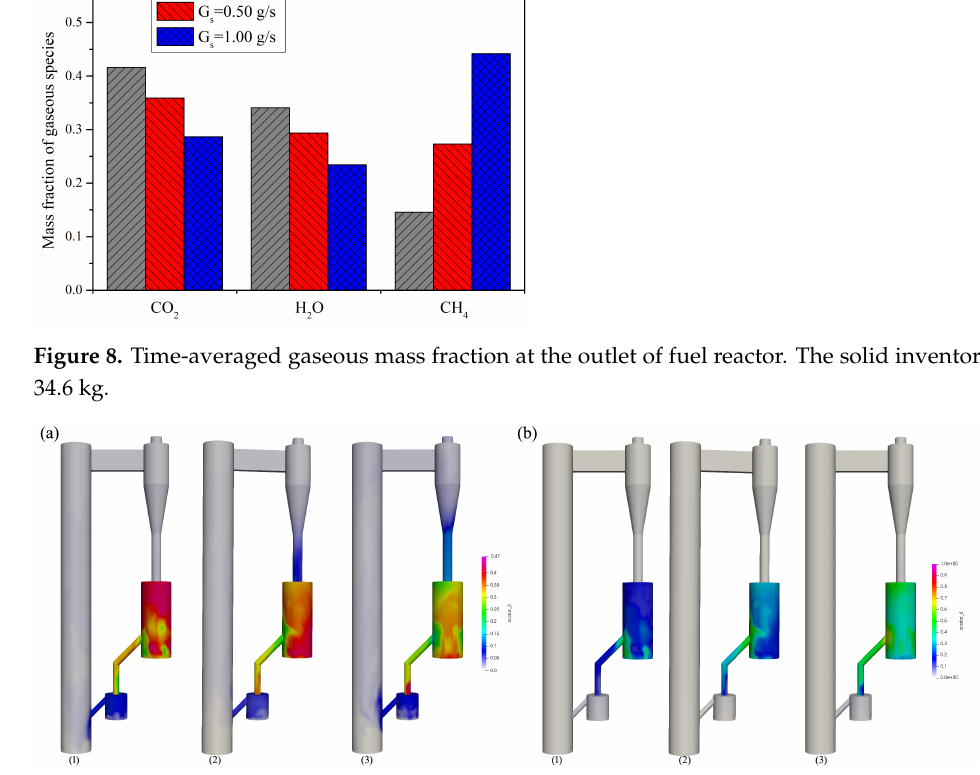
Figure 9. Instantaneous distribution of gas species with different inlet rate of methane. ( a ) CO 2 . ( b ) CH 4 . (1) 0.25 g/s. (2) 0.5 g/s. (3) 1.0